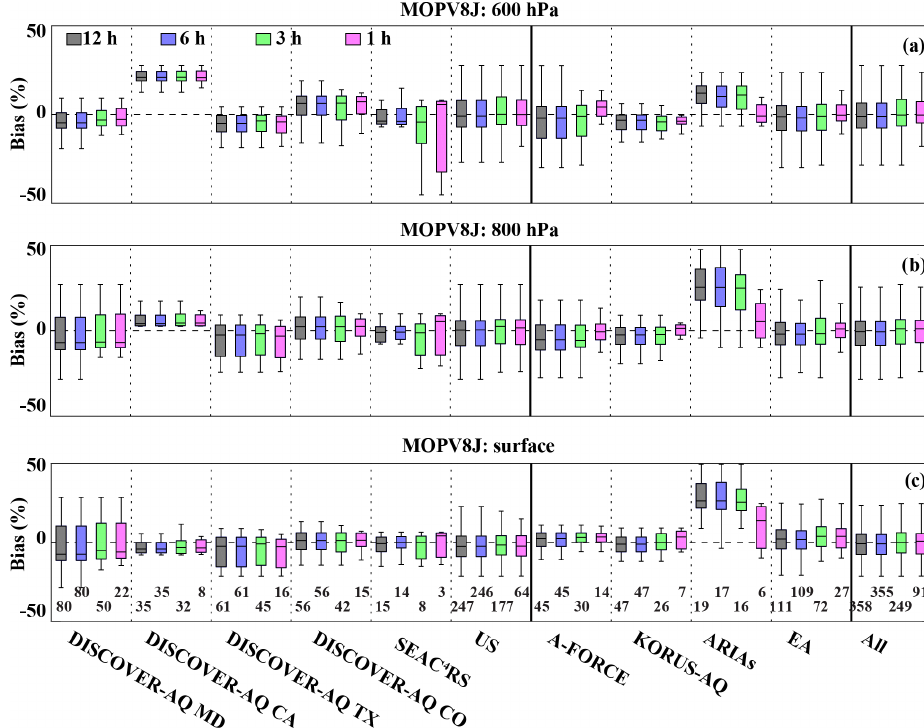
Figure 10. Sensitivity to the allowed maximum time difference as criteria for co-location. Biases (%) using 12h (gray), 6h (blue), 3h (green), and 1h (pink) as the allowed maximum time difference for co-location at 600hPa layer (a) , 800hPa layer (b) , and the surface layer (c) are shown by box plot (with medians represented by middle bars, interquartile ranges between 25th and 75th percentiles represented by boxes, and the most extreme data points not considered outliers represented by whiskers). The numbers in (c) correspond to the number of in situ profiles qualified for validation within the given allowed maximum time difference. The biases are calculated against all (both urban and non-urban) in situ profiles listed in Table 1. The “12 h” values (gray bars) are the same as yellow bars (for all data) in Fig. 6. See the caption of Fig. 6 for the definition of